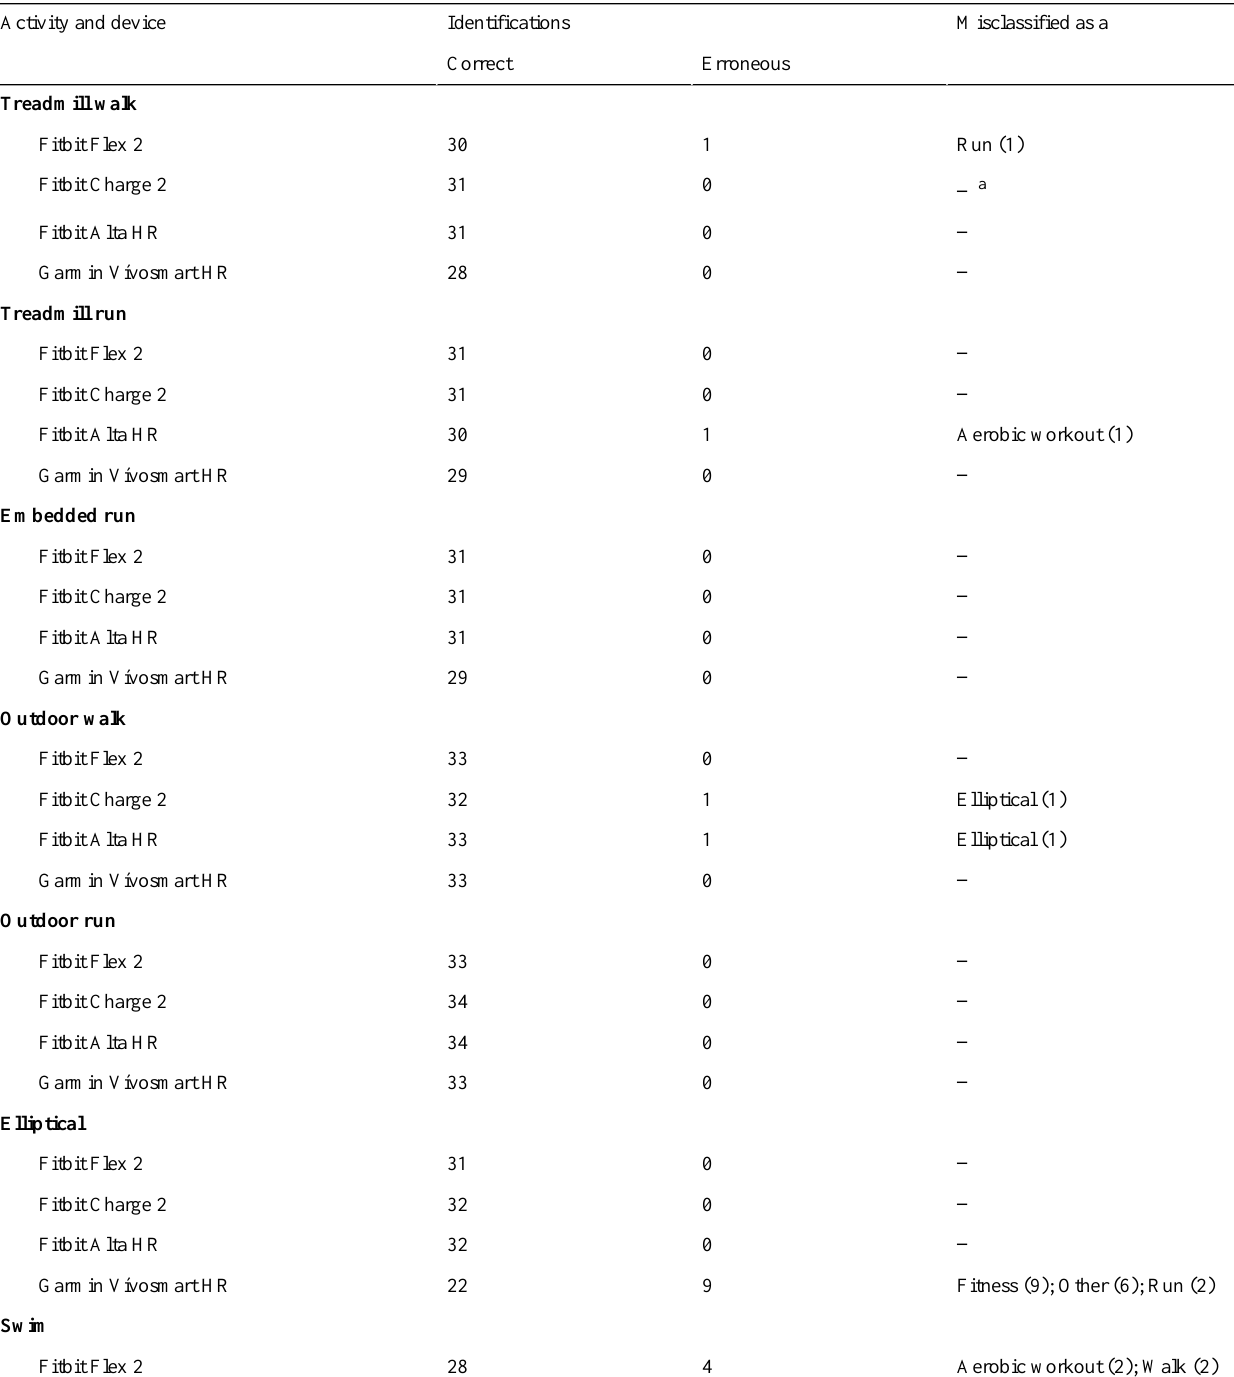
Table 2. Confusion matrix of activity identifications by actual activity type and